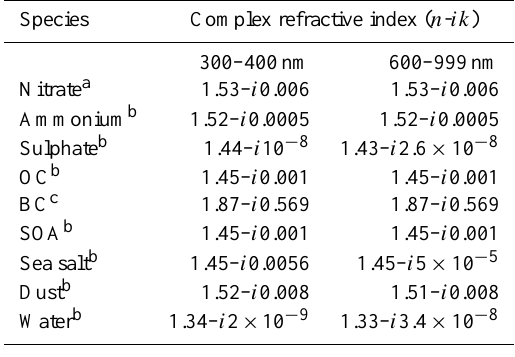
Table 1. Wavelength-dependent complex refractive index of each chemical species used to perform optical calculation. n and k are, respectively, the real and imaginary parts of the complex refractive